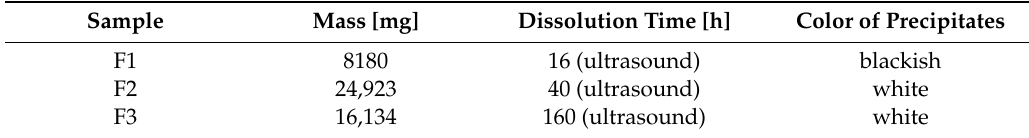
Table 14. ICP-OES and ICP-MS analysis results and conversion to units [ mg/kg ] and [ % ] .